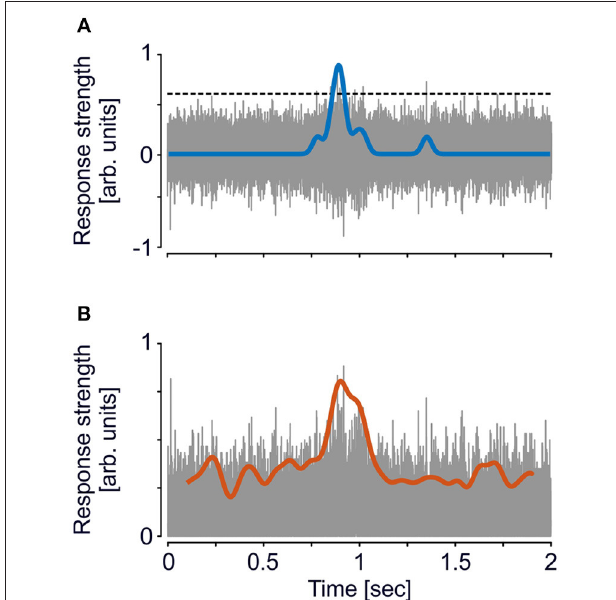
FIGURE 1 | Exemplary trace of a single-trial illustrating analysis of MUA and ESA. (A) For MUA, a threshold (dashed line, cf. equation 1) based on the method introduced by Quiroga et al. (2004) was applied to the high-passed signal (gray trace). All events surpassing the threshold were then used for calculating the SDF (blue line). (B) For ESA, analysis is based on the full-wave rectified signal, i.e., the absolute values of the high-passed signal (gray trace), and then low-pass filtered (red line), using the same filter settings as for the SDF. This computation is independent of setting a threshold. Ordinate scaling is identical in both plots, SDF and ESA traces are both upscaled by a factor of 5 for visual purposes. Note that due to line thickness and time span, gaps between adjacent spike events are hardly visible. The inset in (B) shows a time period of 100ms to illustrate the time course of the rectified signal in more